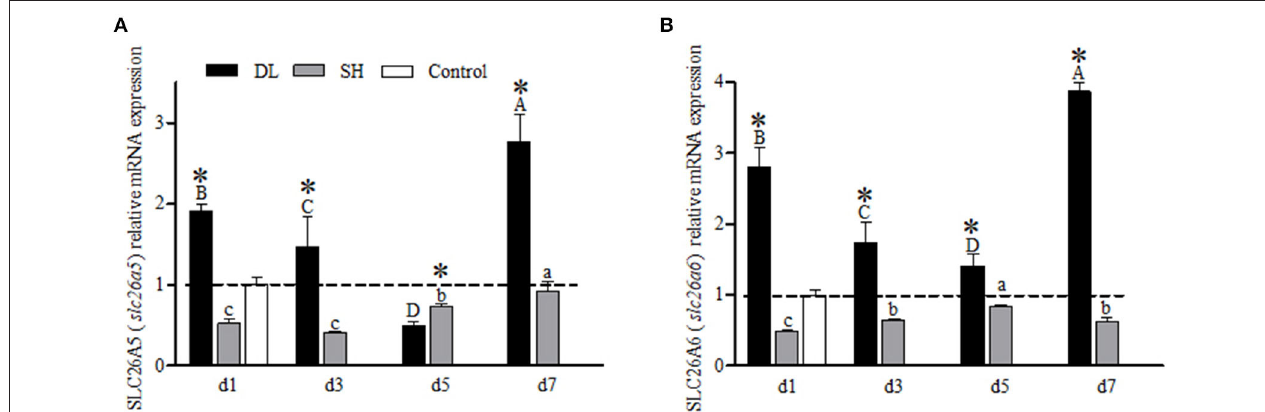
FIGURE 7 | Gill SLC26A5 ( slc26a5 ) and SLC26A6 ( slc26a6 ) mRNA levels ( n = 3) for DL (the alkali form introduced from Lake Dali Nor) and SH (the freshwater form introduced from Songhua River) fish forms. Different uppercase letters indicate significant differences within DL, and different lowercase letters indicate significant differences within SH. The asterisk (*) denotes a significant difference found in the SLC26A5 or SLC26A6 mRNA levels between DL and SH exposed to bicarbonate AW.